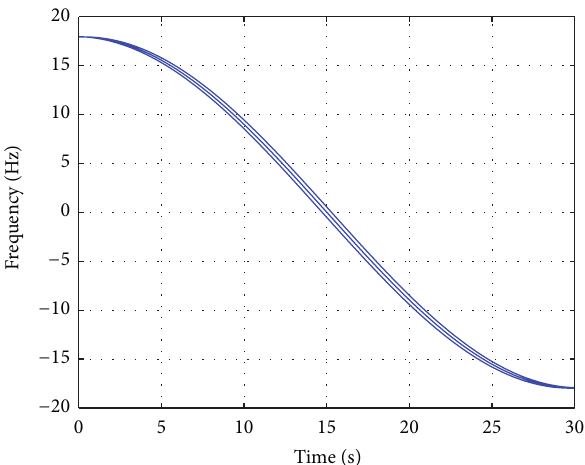
Figure 9: The Doppler frequency curves of the moving target in the earth curvature